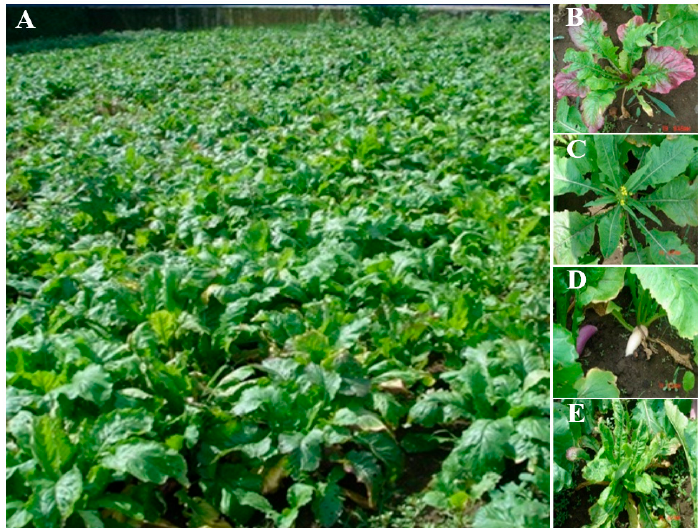
Figure 2. Open field cultivation and phenotypic variations observed in M 1 population: ( A ) open field cultivation of M 1 population generated by EMS; and phenotypic characteristics of abnormal turnips with: purple leaf ( B ); early flowering ( C ); white swollen root ( D ); and curly leaf ( E ).